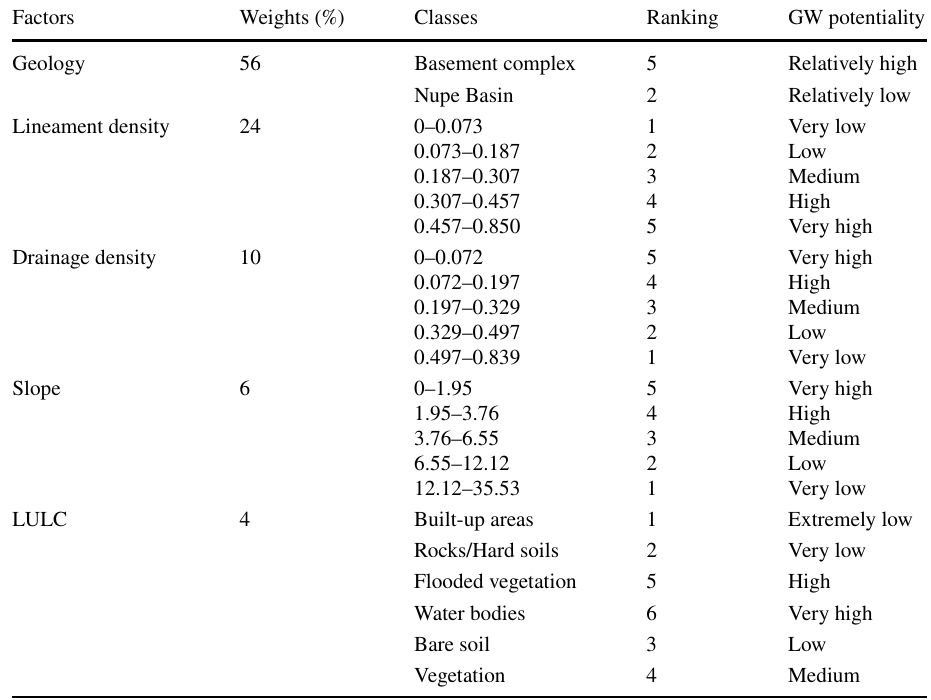
Table 7 Weights of factors and ranking of their